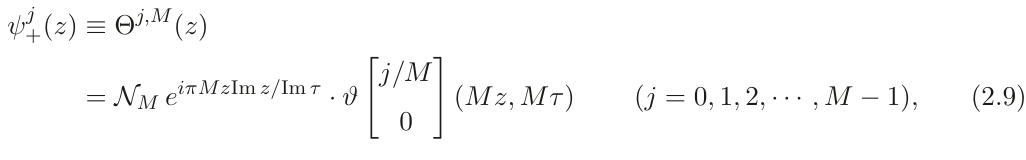
C , where an angle between y ∈